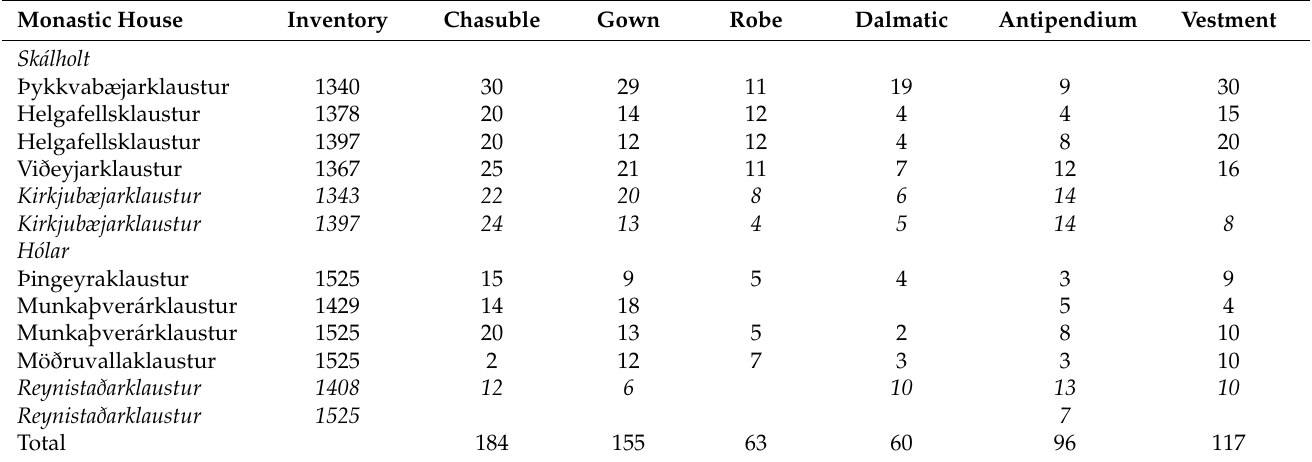
Cattle Sheep Lamb Figure 2. Livestock of the Icelandic monastic houses. The count is based on preserved inventories. Table 3. Ecclesiastical garments owned by the monastic houses. The female convents are emphasized in italics (Kristjánsdó tt ir 2023, p. 164).